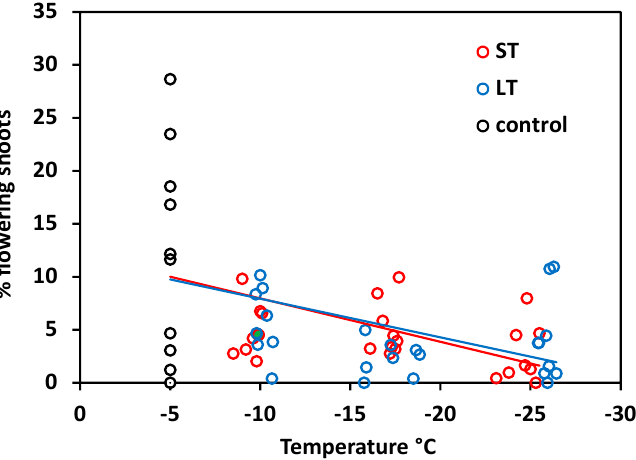
Figure 9. Saxifraga bryoides L. Flowering frequency of control individuals (black circles), and individuals after short-time (ST, red circles) and long-time (LT, blue circles) exposure that had been exposed to different freezing temperatures in winter. Each symbol indicates the proportion of flowering shoots based on the total number of shoots (generative and vegetative) per individual. Trend lines indicate linear regressions.